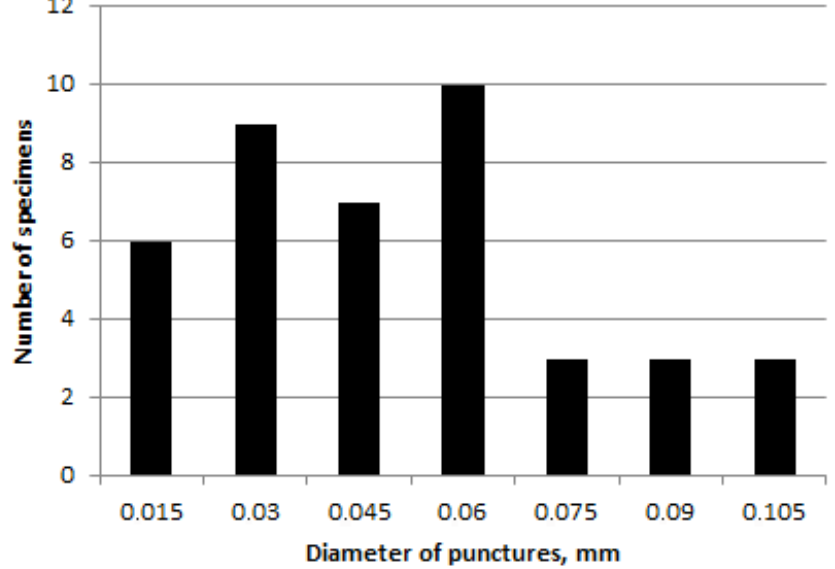
Figure 3. Chrysolina fascinatrix , diameter of punctures in 5th elytral row.